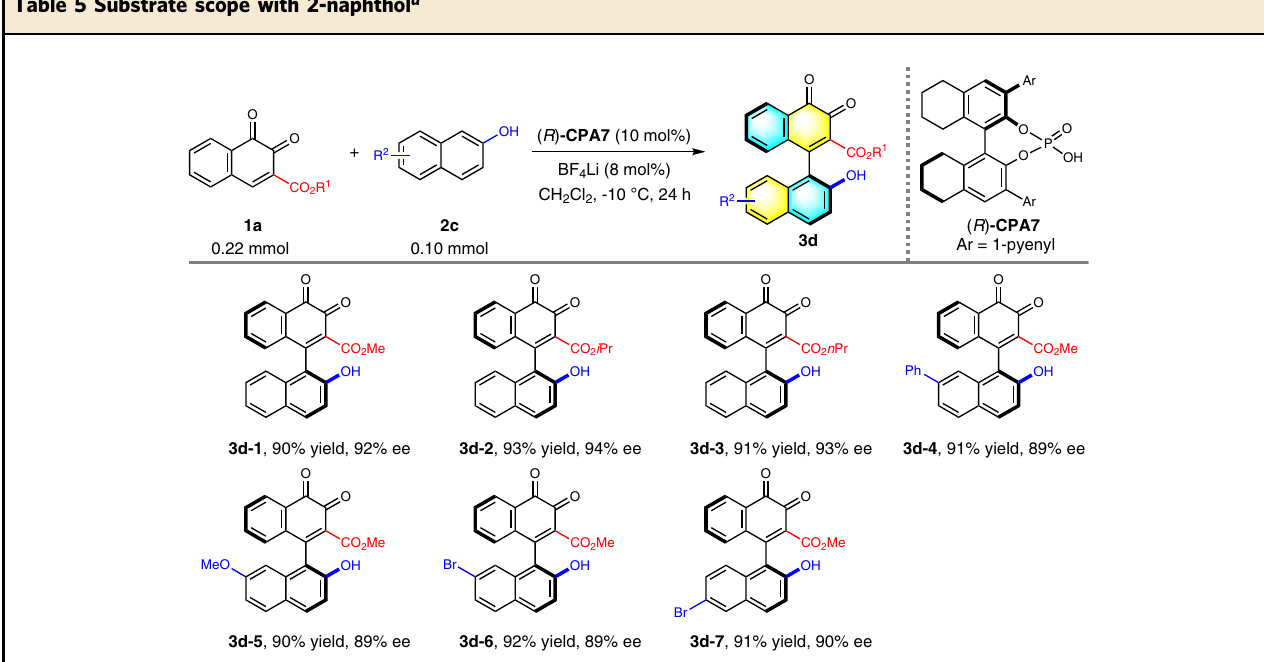
Table 5 Substrate scope with 2-naphthol